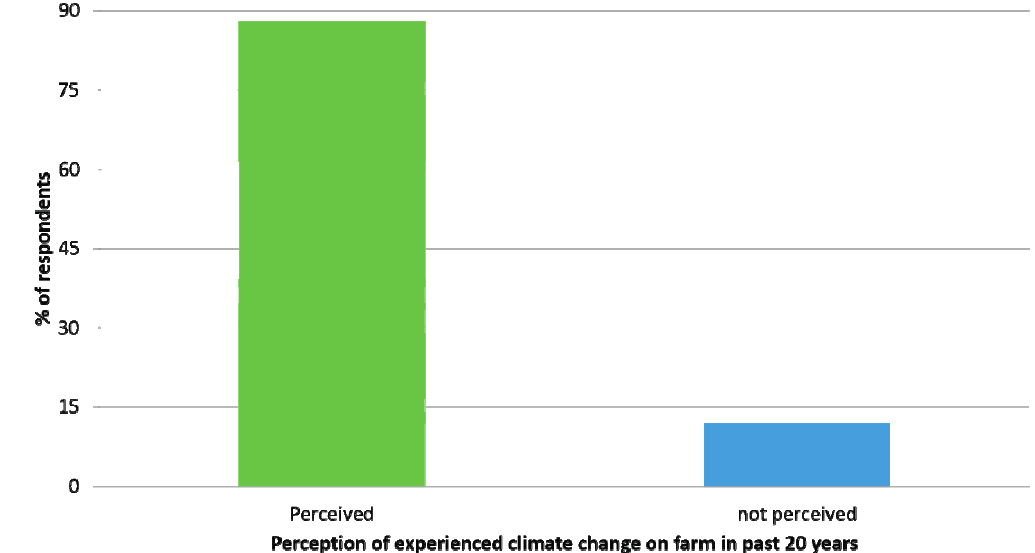
Table 2. Distribution of responses to perceived changes in specific climatic events ( n =